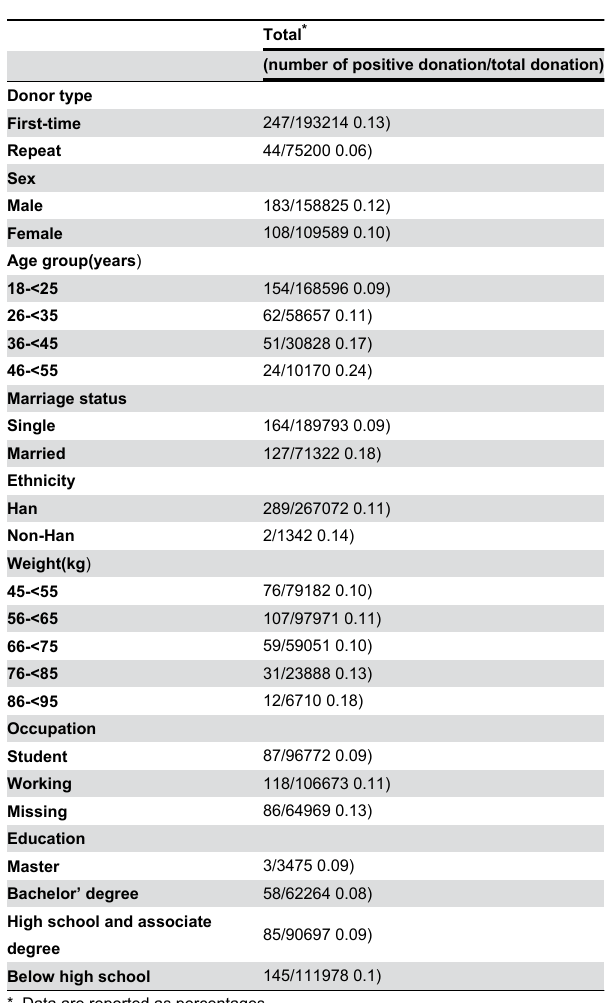
Table 4. Demographic characteristics of HBsAg positive donors in Anhui from 2009 to